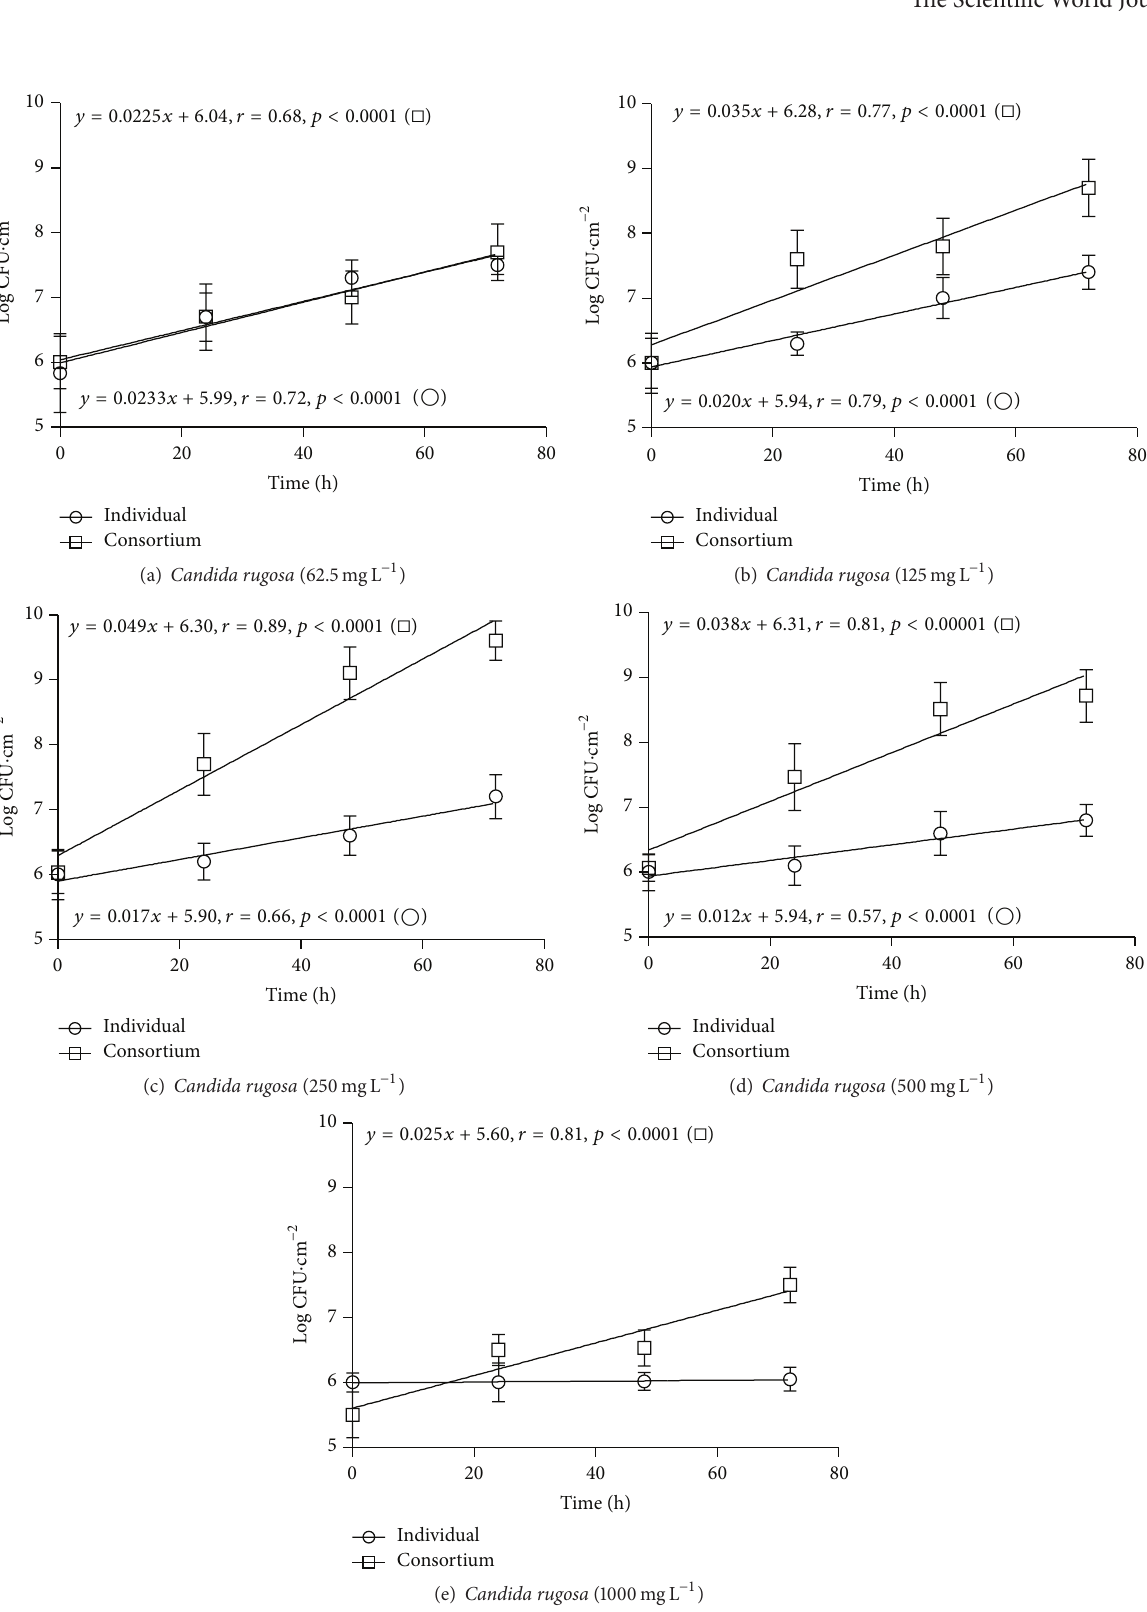
Figure 3: Growth curves of Candida rugosa on polyurethane foam, as an individual culture ( I ) and in a consortium with Serratia marcescens ( ◻ ), at phenol concentrations of (a) 62.5 mg L −1 , (b) 125 mg L −1 , (c) 250 mg L −1 , (d) 500mg L −1 , and (e) 1000 mg L −1